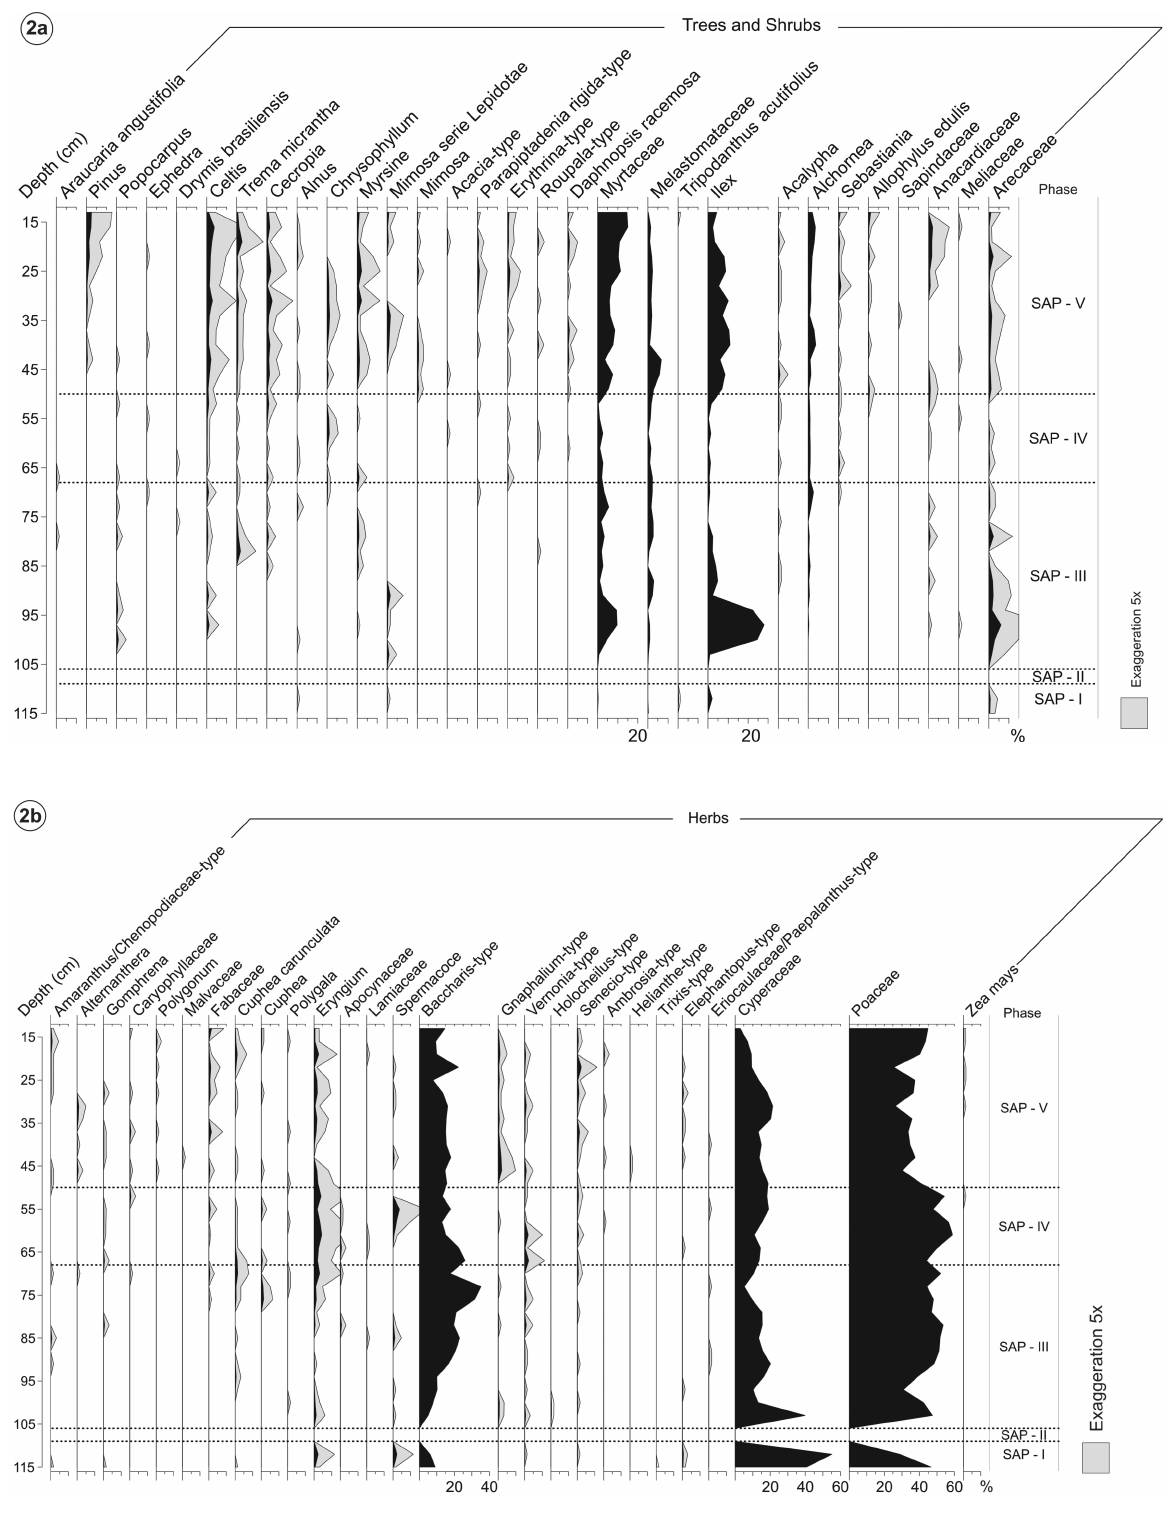
Fig. 2 – Pollen diagram percentages of Trees and Shrubs (a) , Herbs (b)